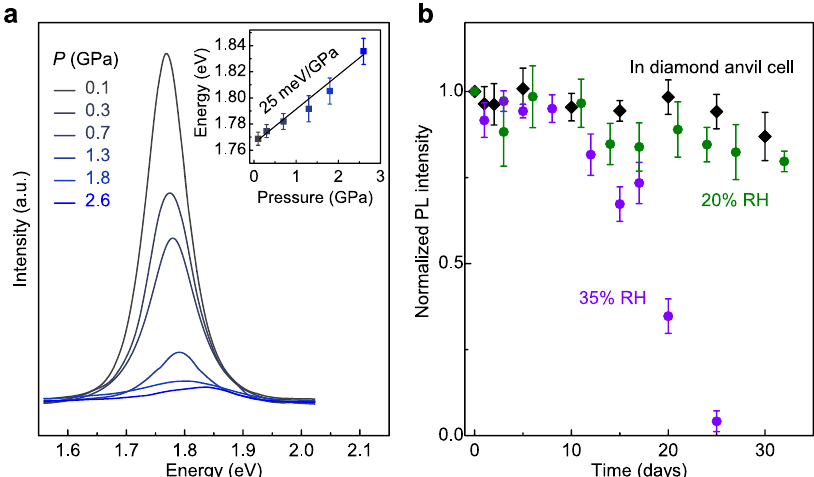
Fig. 4 PL spectra of re-pressurizing the recovered γ -CsPbI 3 perovskite and PL intensity over time of the preserved γ -CsPbI 3 . a PL spectra collected as a function of pressure at room temperature. Inset: The pressure dependence of the PL energy. A pseudo-Voigt function is used to fi t the PL peak that yields the peak position and uncertainty. b Normalized PL intensity of the preserved γ -CsPbI 3 perovskite over time in a diamond – anvil cell and in air at 20% and 35% RH, respectively. The error bars are de fi ned as the largest deviation from the average value of the normalized PL intensity collected at different sample